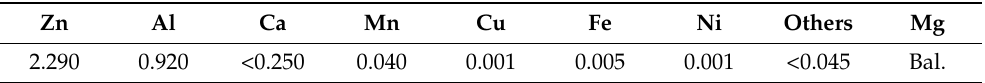
Table 1. Chemical composition of the ZAX210 sheets (wt.%) measured by optical emission spectrom- etry